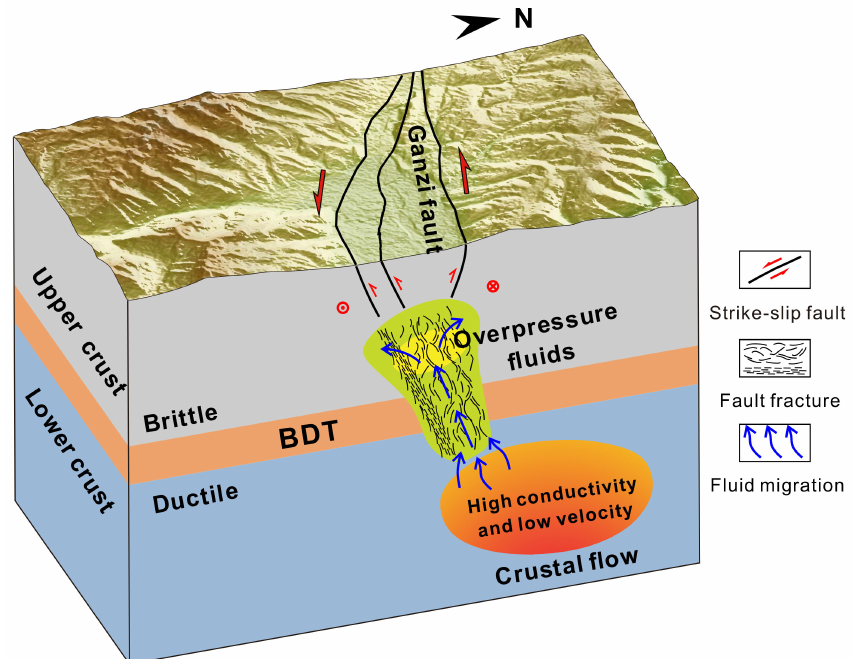
Figure 11. Schematic diagram interpretation of resistivity features related to fluid migration in the crust. Blue arrows indicate the upward migration of fluids originating from the lower crustal flow through fault fracture (black lines) and accumulation in the upper crust to form overpressure fluids. BDT represents brittle ductile transition. The red arrow indicates the shearing directions inferred from geologic and geodetic observations at the